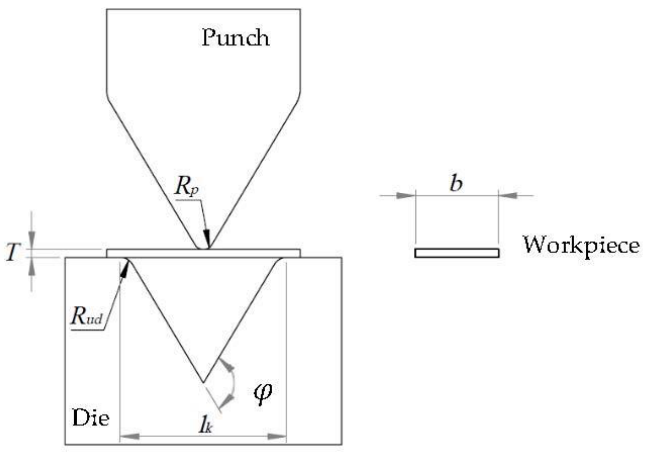
Figure 2. Illustration of a bending model and its